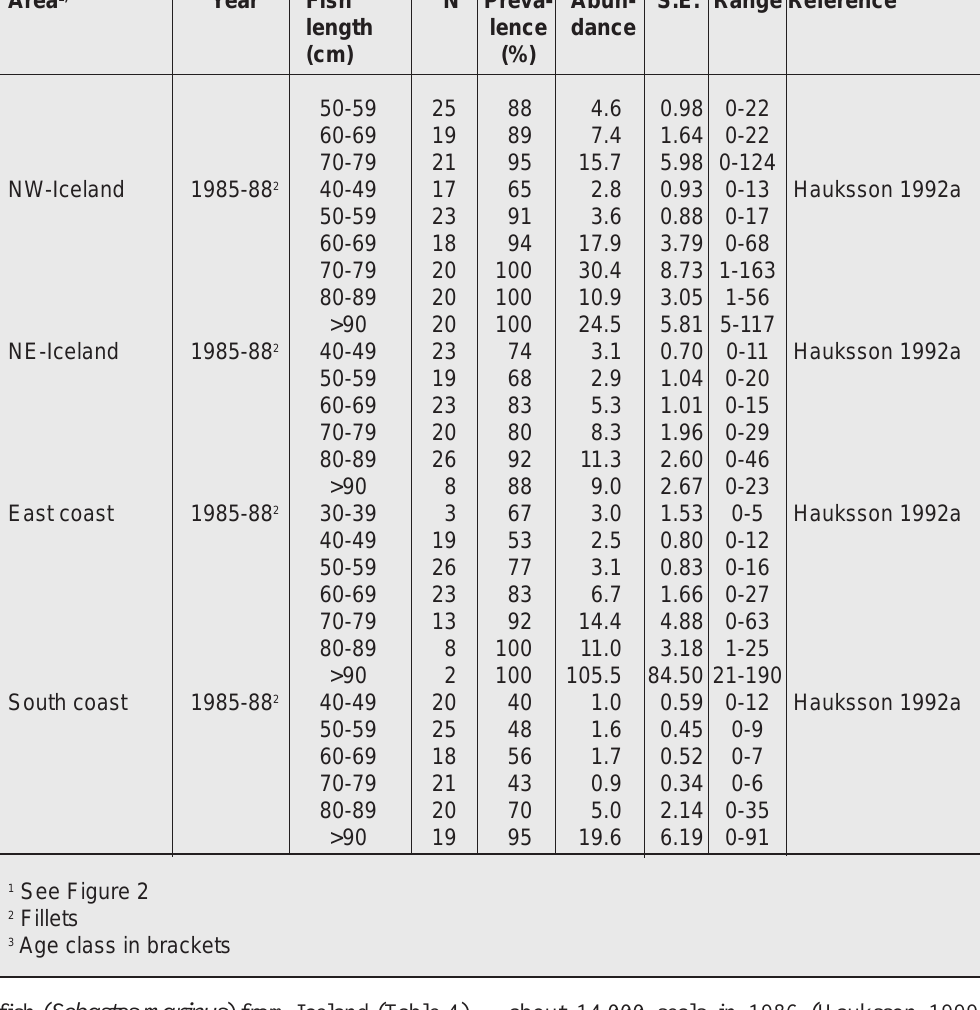
Fig. 2 Distribution of common seals